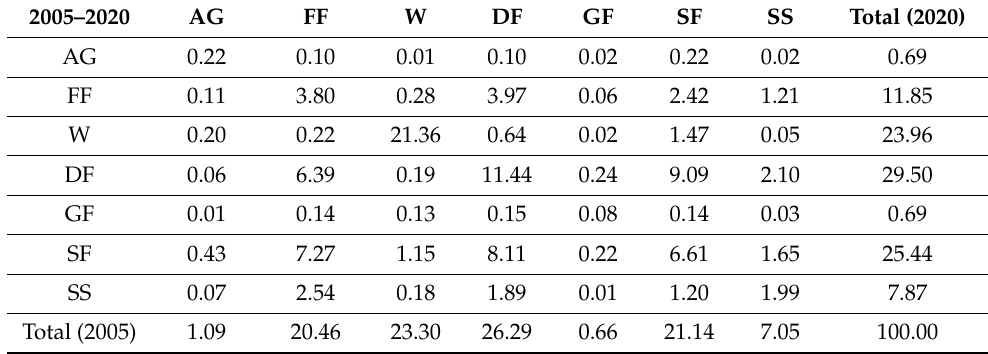
Table 4. Transition matrix of landscape units (%) between 2005 and